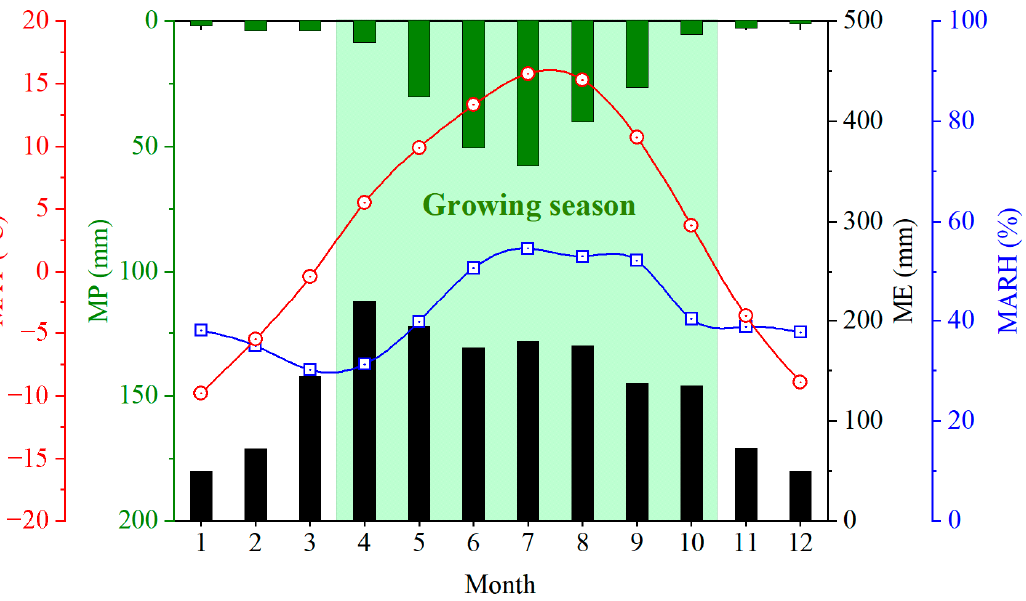
Figure 7. Monthly variations of climate factors. MAT, MP, ME, MARH represent Monthly average Temperature, Monthly Precipitation, Monthly Evaporation, and Monthly Average Relative Humidity, respectively.